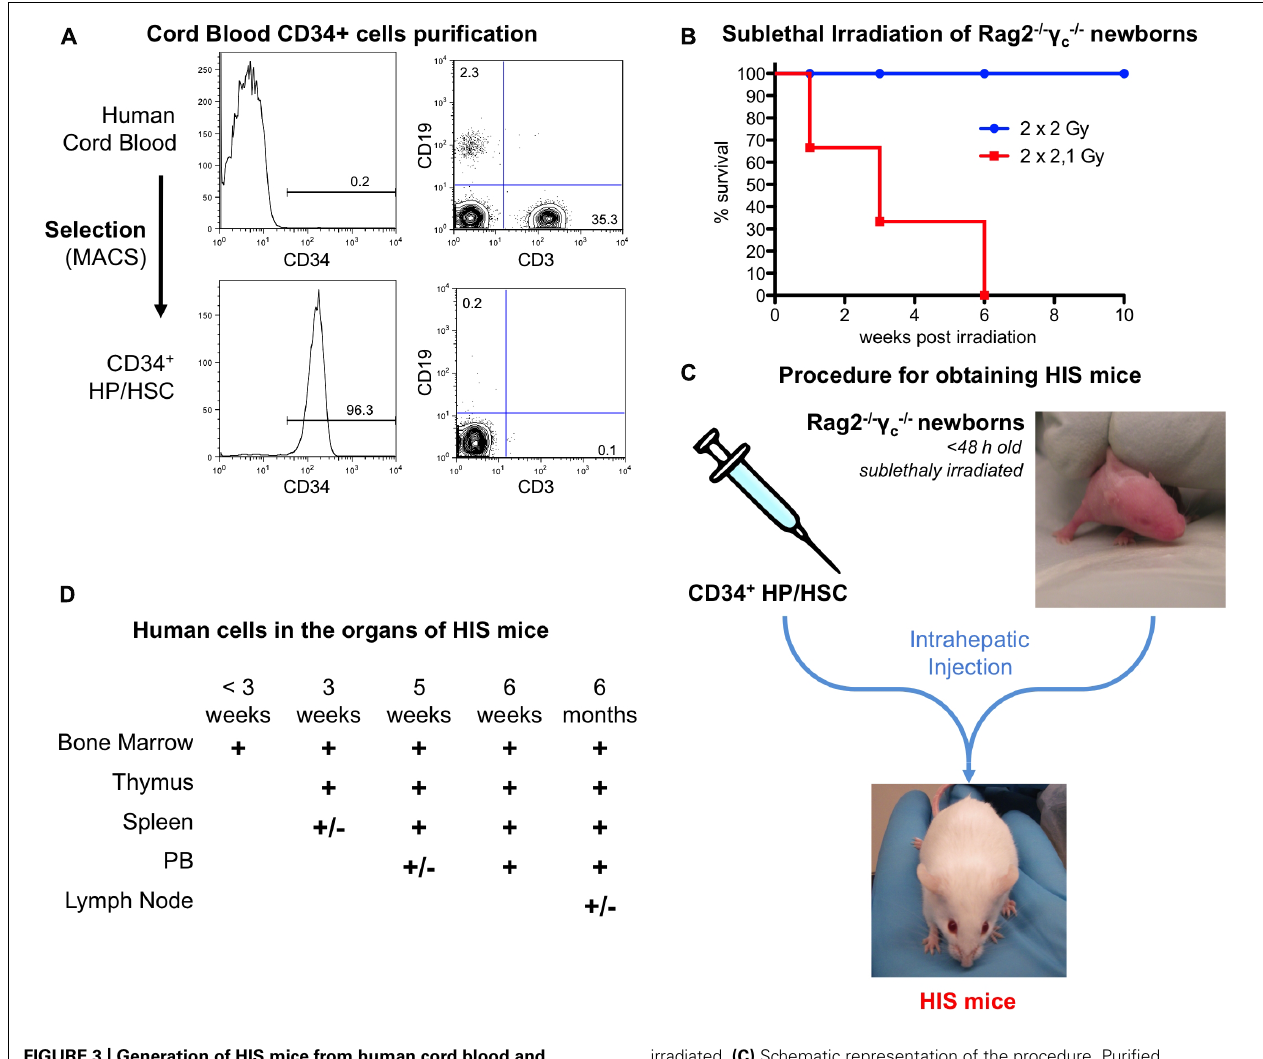
irradiated. (C) Schematic representation of the procedure. Purified CD34 + cells are injected into the liver of sublethally irradiated Rag2 − / − γ c − / − newborns.This results in the development of a human adaptive immune system in the HIS mice. (D) Sequential colonization of the different murine organs by human cells.The humanization can be observed for several months after birth. + / − , less than 5%; + ,